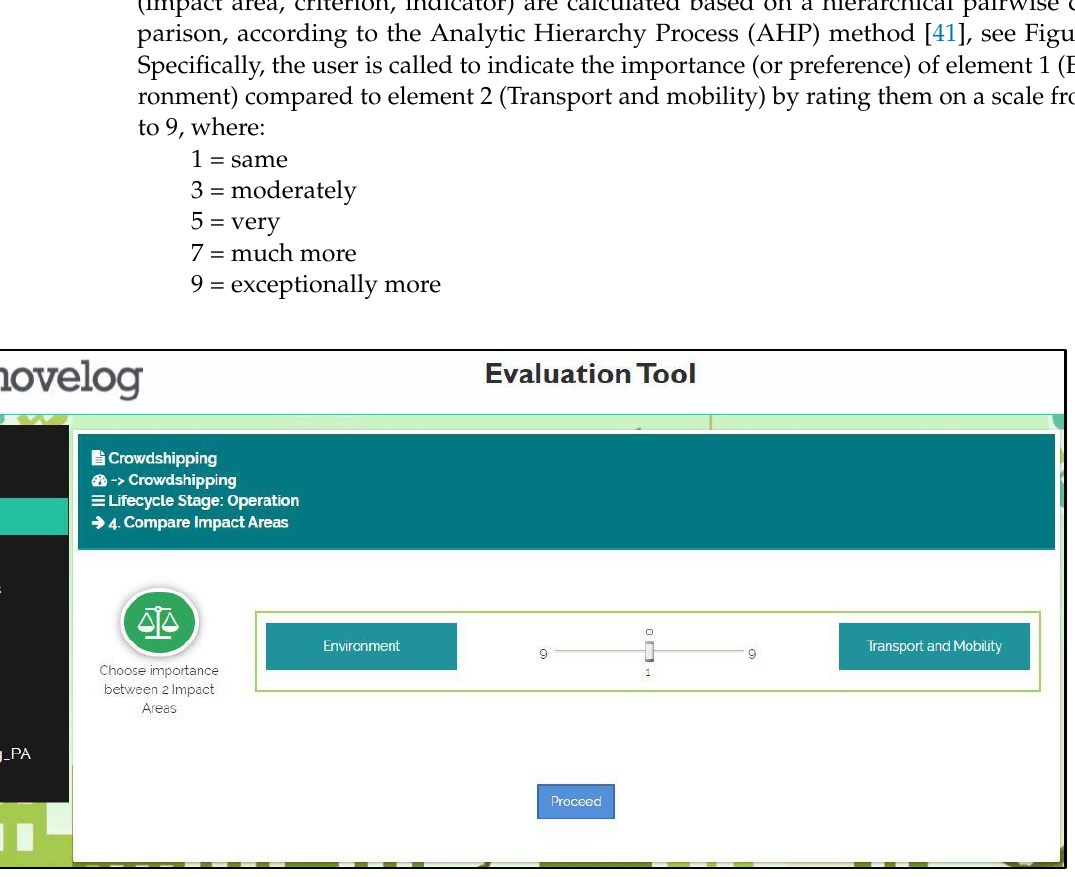
Figure 3. Exemplifying screenshot of Evalog’s weighing process.